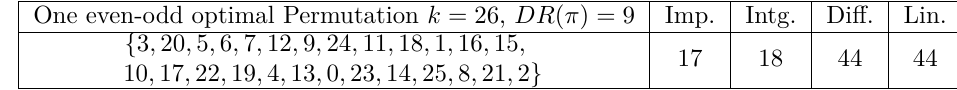
Table 21: One optimal even-odd permutation for k = 26 One even-odd optimal Permutation k = 26, DR ( π ) = 9 Imp. Intg. Diff.